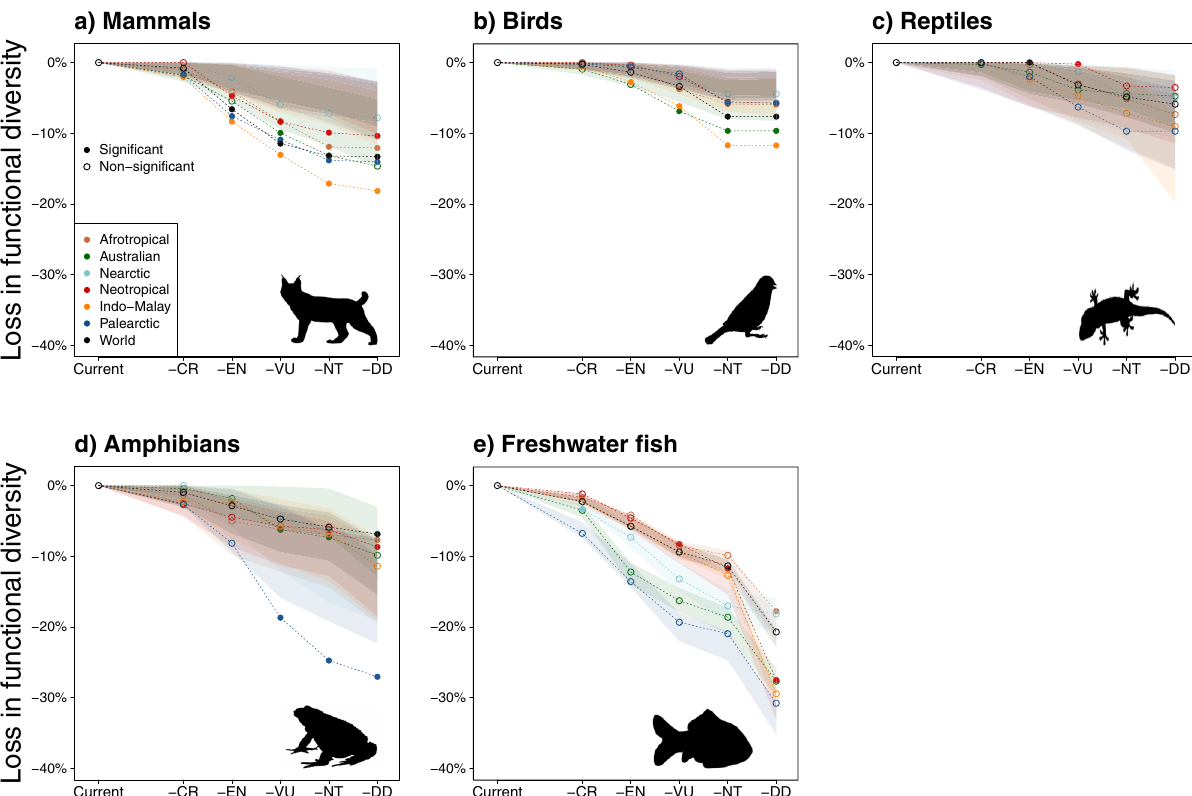
Fig. 3 Simulated losses of functional diversity under fi ve extinction scenarios. For each taxonomic group (panels a – e ) and in each biogeographic realm (and the world), the loss of functional diversity is expressed as a percentage of the current functional diversity of the biogeographic realm (or the world). We simulated the loss of functional diversity by removing all species from the IUCN category in a progressive framework. We started removing the species with a higher risk of extinction (i.e. -CR), then we continued progressively removing the species from the categories with lower threatened risks (-EN: CR + EN, -VU: CR + EN + VU, -NT: CR + EN + VU + NT, -DD: CR + EN + VU + NT + DD). In the fi gure, the name of the scenario refers to the lower IUCN threat category simulated as extinct (e.g. -EN scenario considers extinctions of all CR and EN species). For each scenario, we compared the loss of functional diversity with 999 repetitions of a null model where threatened species were randomly selected among all the species present in the corresponding realm. The 999 losses of functional diversity are represented for each realm as a polygon of the con fi dence interval at 95%. The open circles depicted a simulated loss not signi fi cantly different than expected under the null model whereas close circles depicted a simulated loss signi fi cantly higher or lower than expected under the null model, and thus outside their correspondent polygon. Silhouettes were downloaded from PhyloPic (www.phylopic.org). Figures have been made using R (codes are available online, see ‘ Code availability ’ ). Source data are provided as a Source data fi